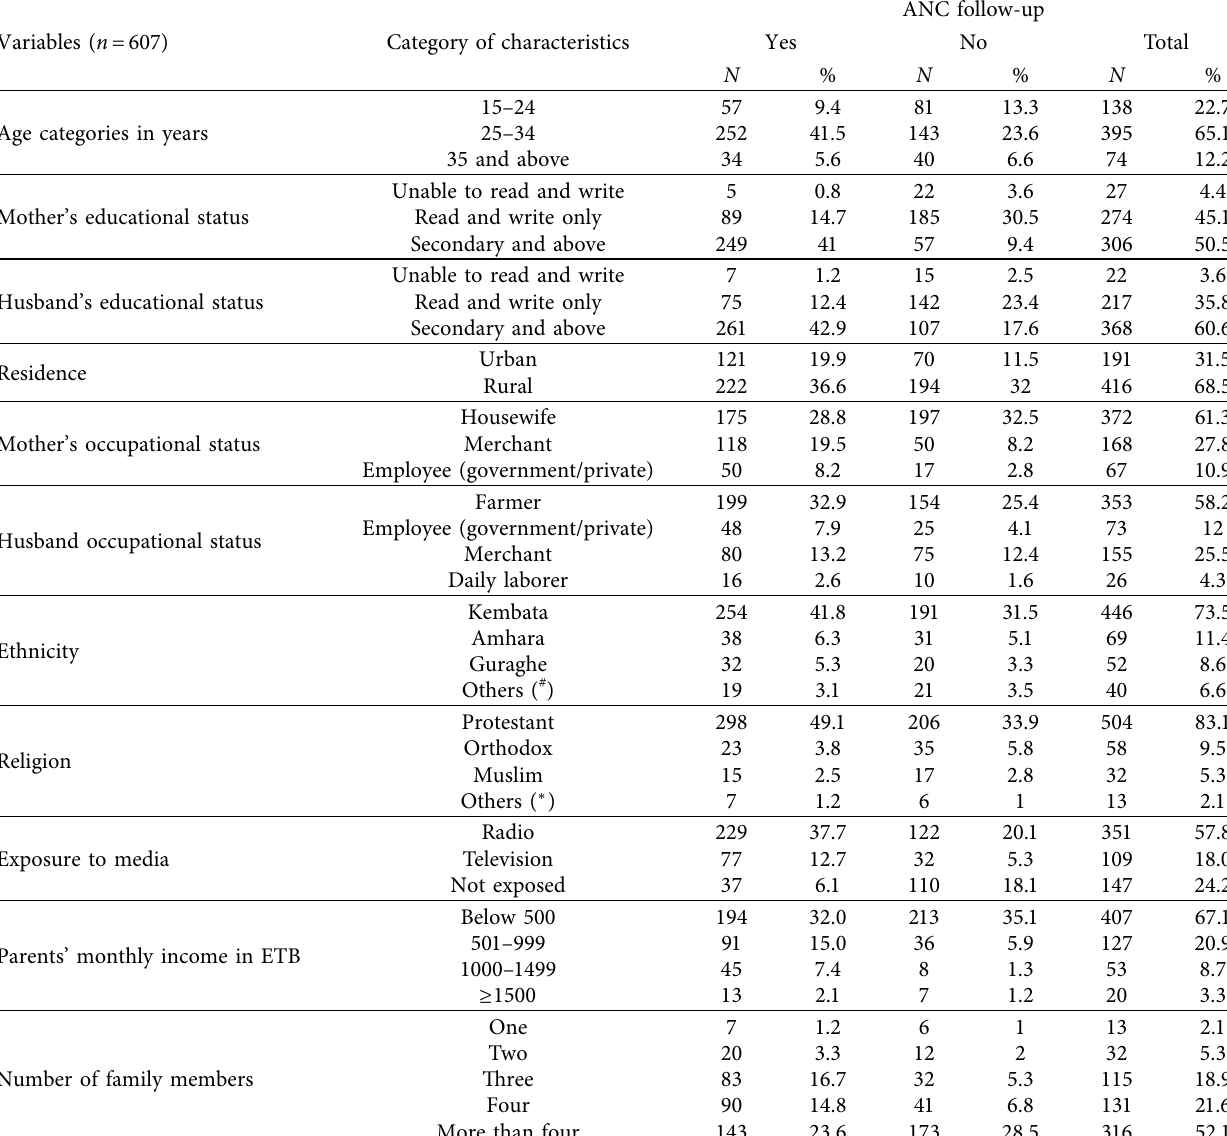
Table 1: Sociodemographic and socioeconomic characteristics of respondents in the Kembata Tembaro zone, 2020. Variables ( n �